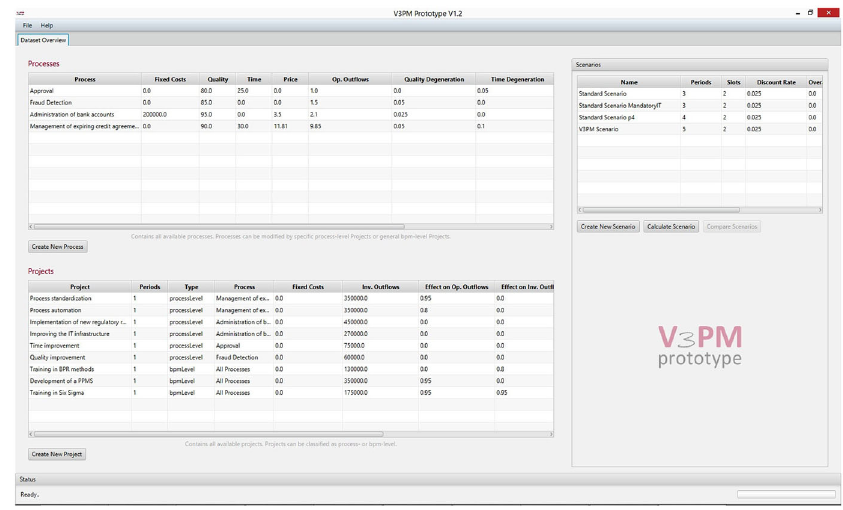
Fig. 3 Software prototype—input